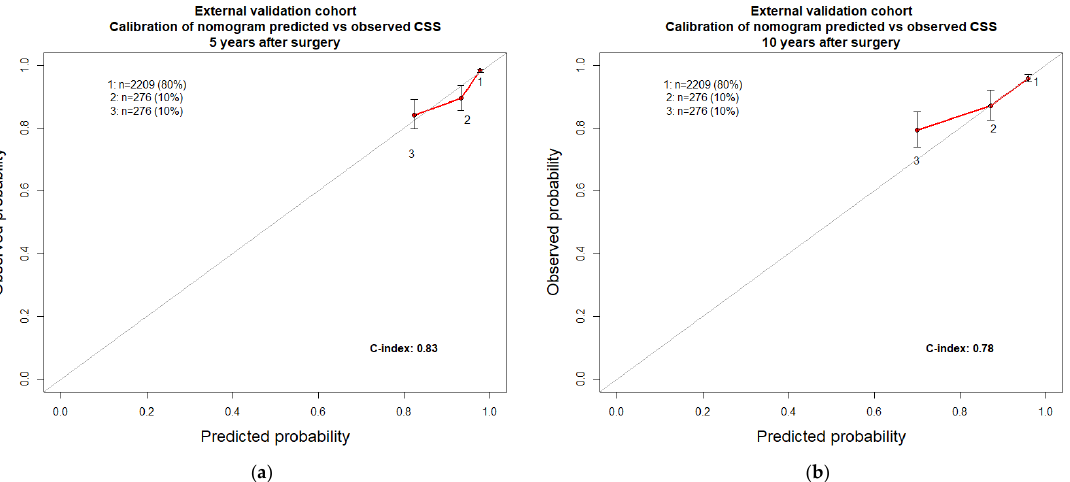
Figure 4. External validation cohort: nomogram calibration plots. CSS: cancer - specific survival. ( a ) Cancer - specific survival at five years; ( b ) cancer - specific survival at ten years.